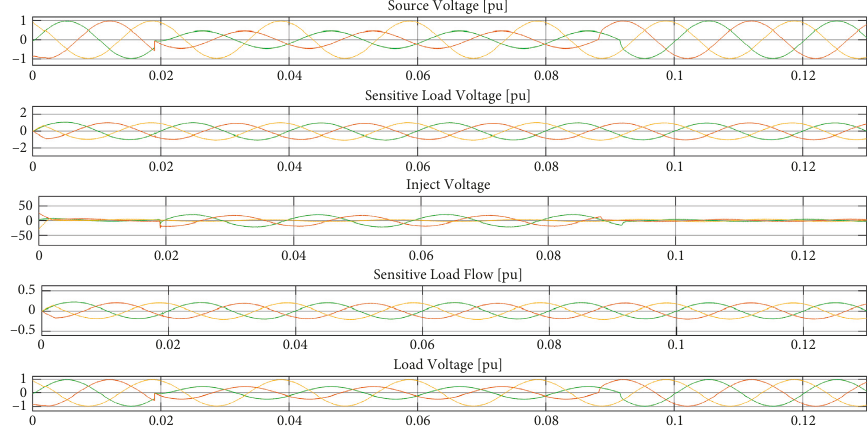
Figure 23: The result of compensating voltage sag in two-phase ground fault (by traditional strategy). Rectifier module